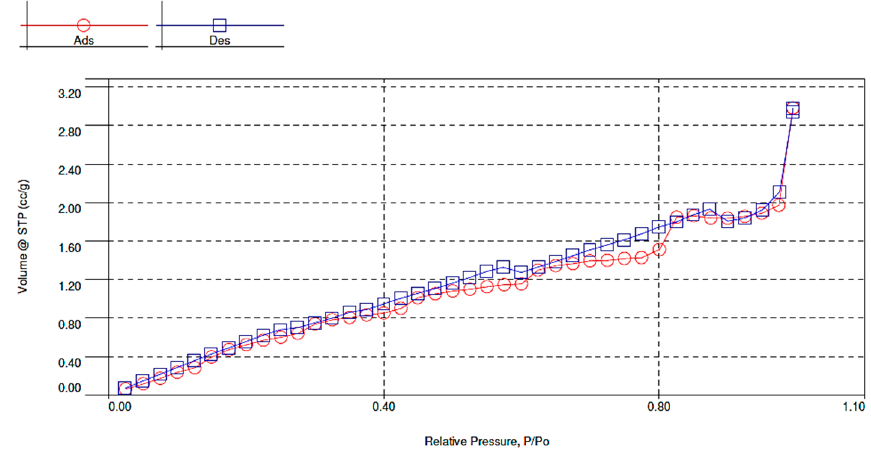
Figure 4. Linear form of the BET adsorption and desorption isotherm of brewer’s grains.